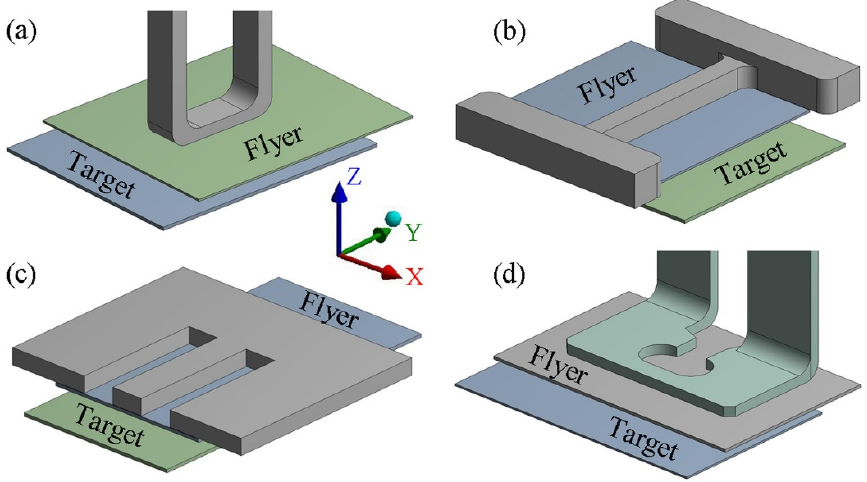
Figure 2. Flat EM coils with ( a ) rectangular-shaped, ( b ) H/I-shaped, ( c ) E-shaped, and ( d ) O-shaped cross-sections for MPW of sheets.